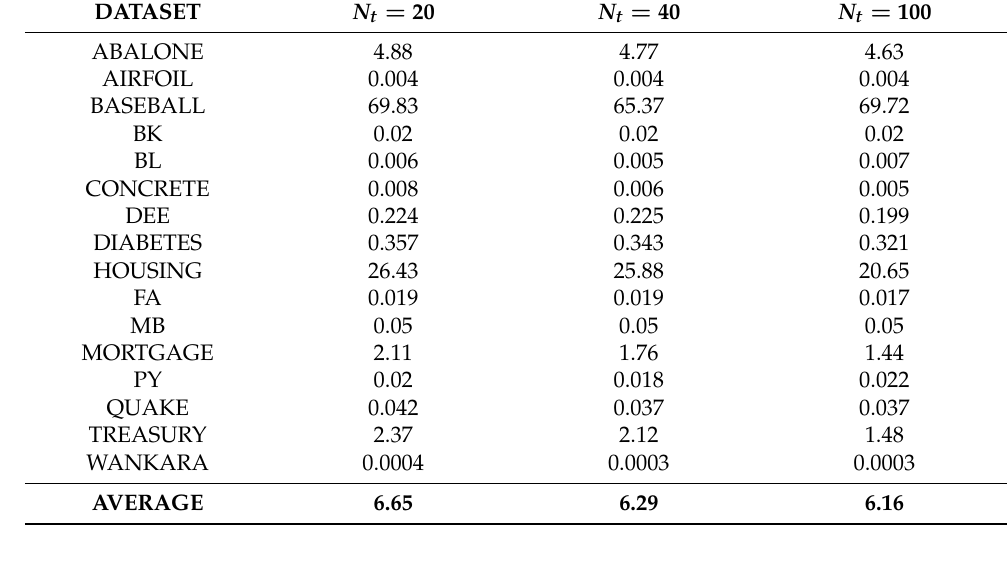
Table 5. Experiments with different values of N t parameter for the regression datasets.